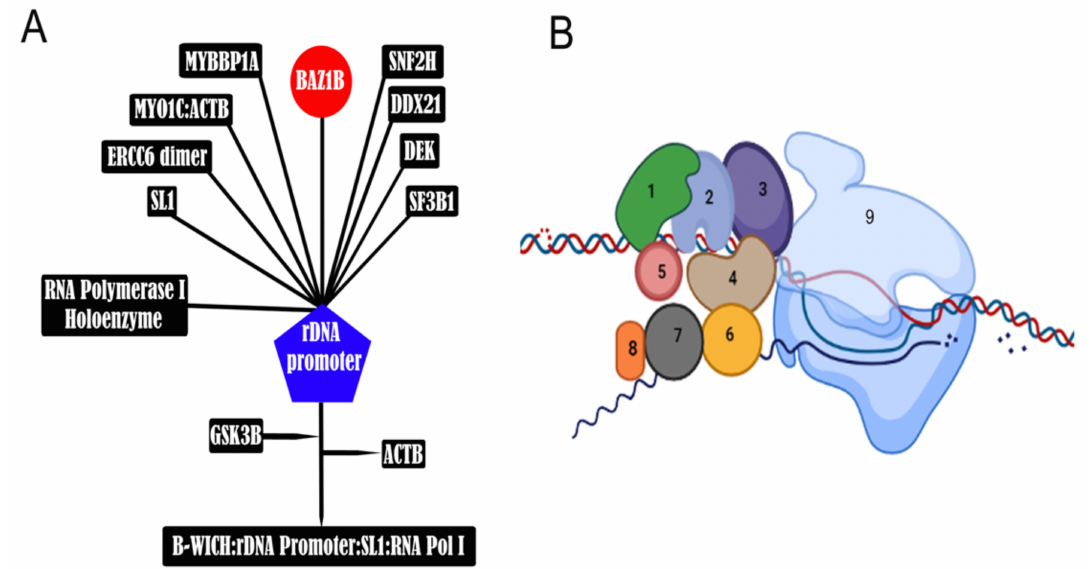
Figure 7. B-WICH is involved in H3K9 acetylation. ( A ) B-WICH multiprotein complex along with SL1 transcription factor binds active rRNA gene promoters forming the B-WICH:rDNA Promoter:SL1:RNA Pol I complex. Upon the formation of this complex, the ERCC6 (CSB) and MYO1C from the B-WICH complex interact with histone acetyltransferases, including KAT2B (PCAF), which acetylates H3K9 as well as KAT2A (GCN5) and KAT3B (EP300). MYO1C binding to chromatin is dependent on phosphorylation by GSK3beta; Note that MYO1C is initially bound to β -Actin (ACTB), which is released after GSK3B phosphorylates MYO1C. MYO1C binding induces open chromatin formation in a 200bp region on rDNA promoter [70]. Activation and maintenance of RNA Pol I transcription requires MYO1C recruitment to active rRNA genes followed by B-WICH binding that will recruit histone acetyltransferases. ( B ) Schematic representation of B-WICH complex next to RNA polymerase in active transcription phase. 1: BAZ1B; 2: SN2H; 3: MYO1c; 4: CSB; 5: DEK; 6: MYBBP1a; 7: